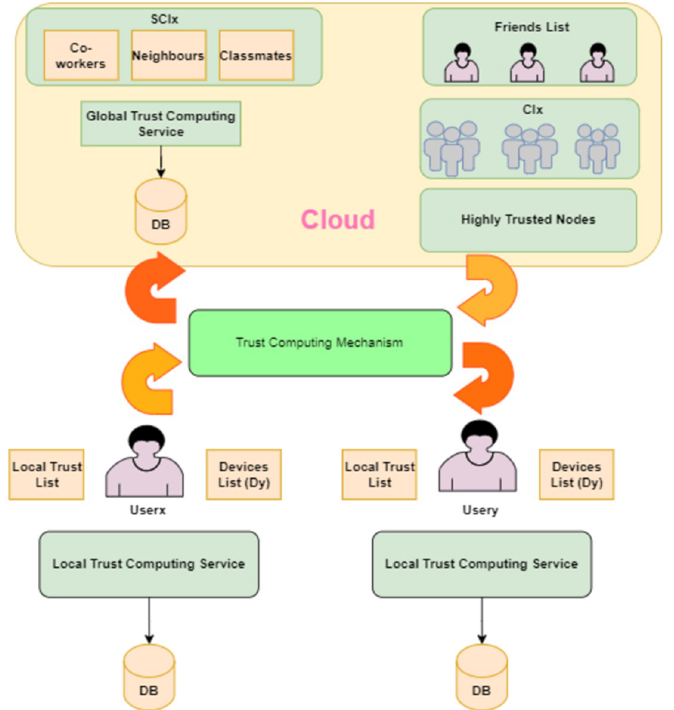
Fig 2. Trust computing high-level functional